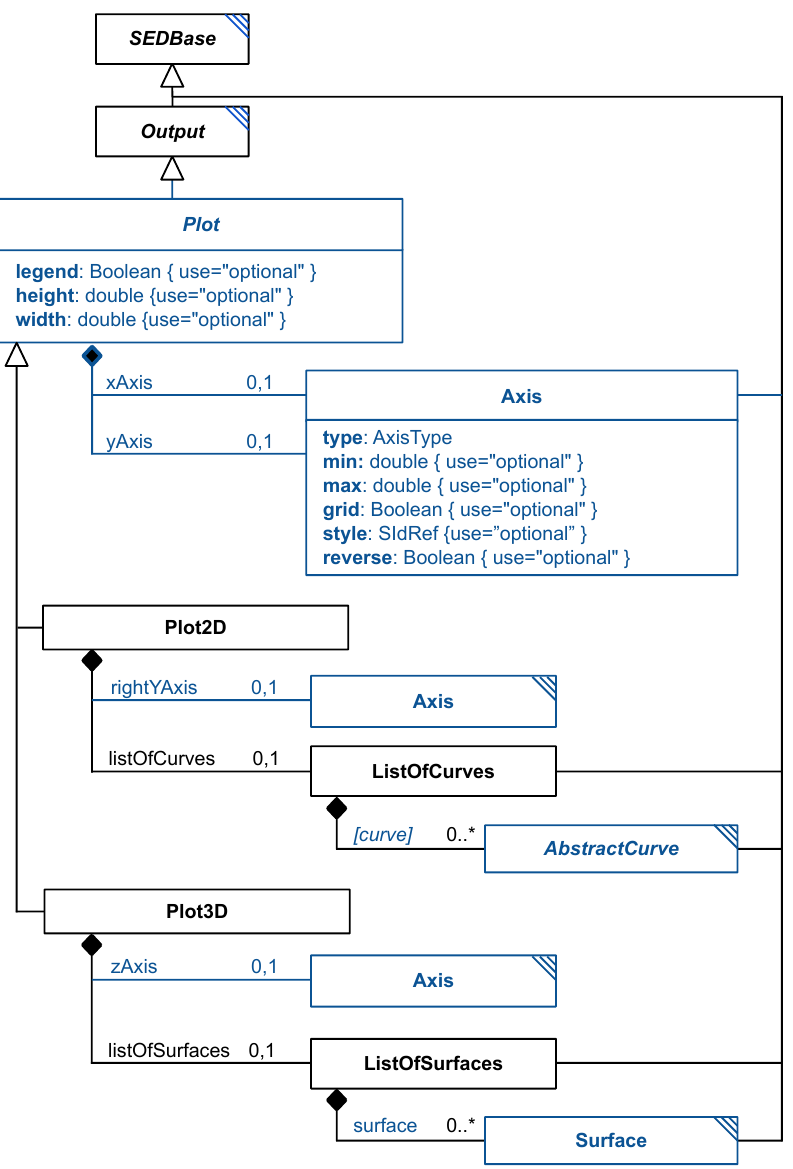
Figure 2.21: The definition of the SED-ML Plot , Plot2D, Plot3D, Axis, ListOfCurves, and ListOf- Surfaces classes. The AbstractCurve and Surface classes are defined